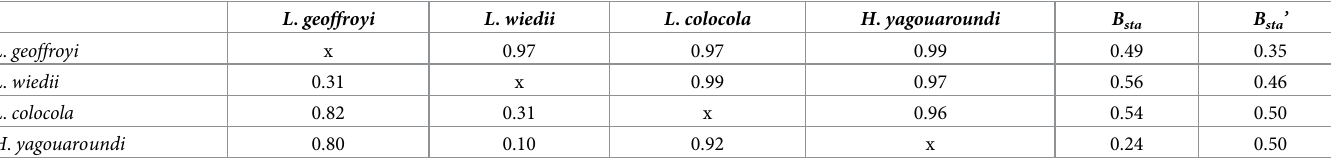
Table 2. Standardized niche breadths ( B ) and food niche overlap between pairs of four sympatric small cat species in the Brazilian Pampa. Values to the left and sta below the x diagonal and B sta were calculated based on the lowest level of prey classification. Values to the right and above are based on broader prey classification ( B sta ’